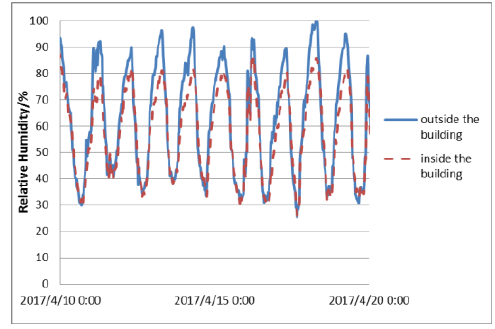
Figure 4 Comparison of relative humidity of microenvironment inside and outside the experimental